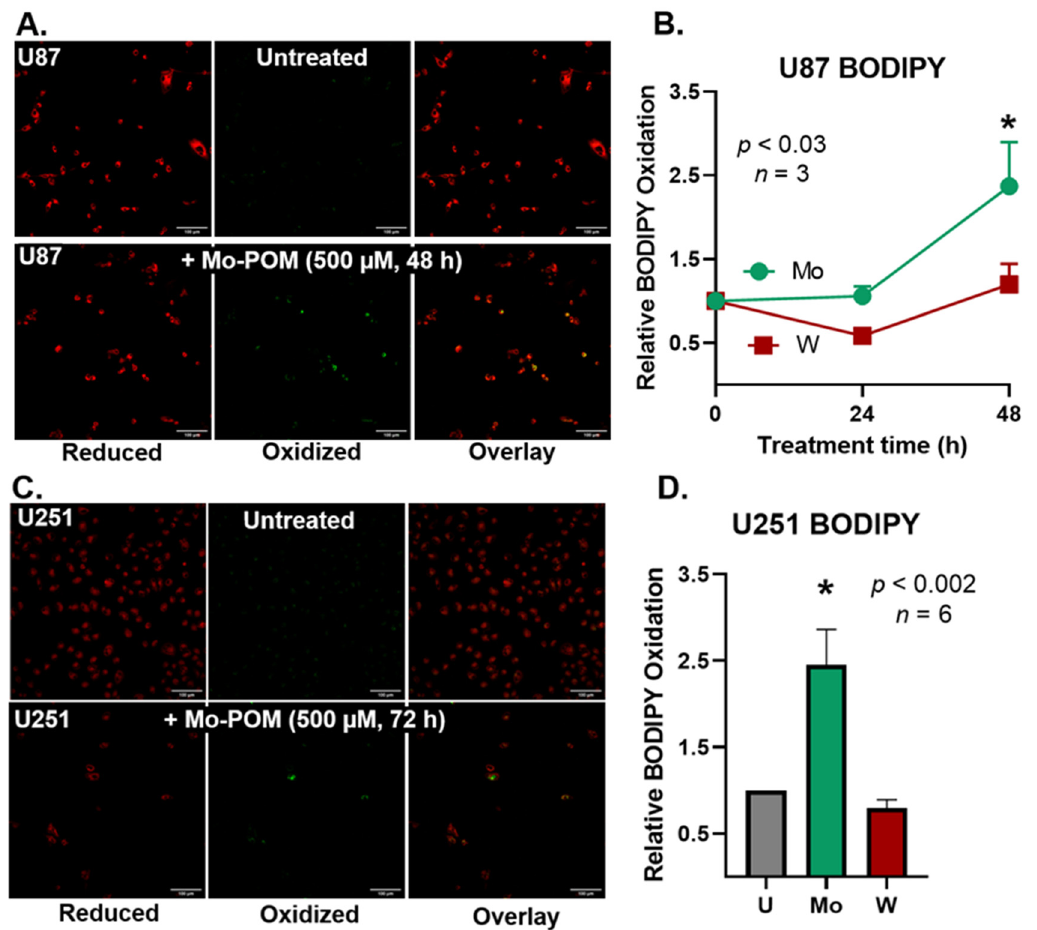
Figure 4. Molybdenum-POMs promote lipid peroxidation in U87 and U251 GBM cells. ( A ) U87 GBM cells cultured in BF15 DMEM medium and treated with 500 µM of Mo-POM (48 h). Incubated for 30 min with BODIPY C11 after treatment. The probe was handled in the dark. There are low amounts of oxidation (green) in the untreated cells, whereas the Mo-POM-treated cells show increased green signals. ( B ) U87 GBM cells treated for 24 or 48 h with Mo- and W-POMs at 500 µM. Three biological replicates were analyzed and plotted. A period of 48 h treatment of Mo-POM increases BODIPY oxidation, reflecting lipid oxidation. However, W-POM does not appear to have any effect, and at 24 h is trending to be more reducing. ( C ) U251 GBM cells cultured in BF15 DMEM medium and treated with 500 µM of Mo-POM (72 h). Incubated for 30 min with BODIPY C11 after treatment. The probe was handled in the dark. There are low amounts of oxidation (green) in the untreated cells, whereas the Mo-POM-treated cells show increased green signals. ( D ) U87 GBM cells treated for 72 h with Mo- and W-POMs at 500 µM. Six biological replicates were analyzed and plotted. 72 h treatment of Mo-POM increases BODIPY oxidation, reflecting lipid oxidation. However, W-POM does not appear to have any effect and is trending to be more reducing. * p < 0.05 using a one-way ANOVA test.